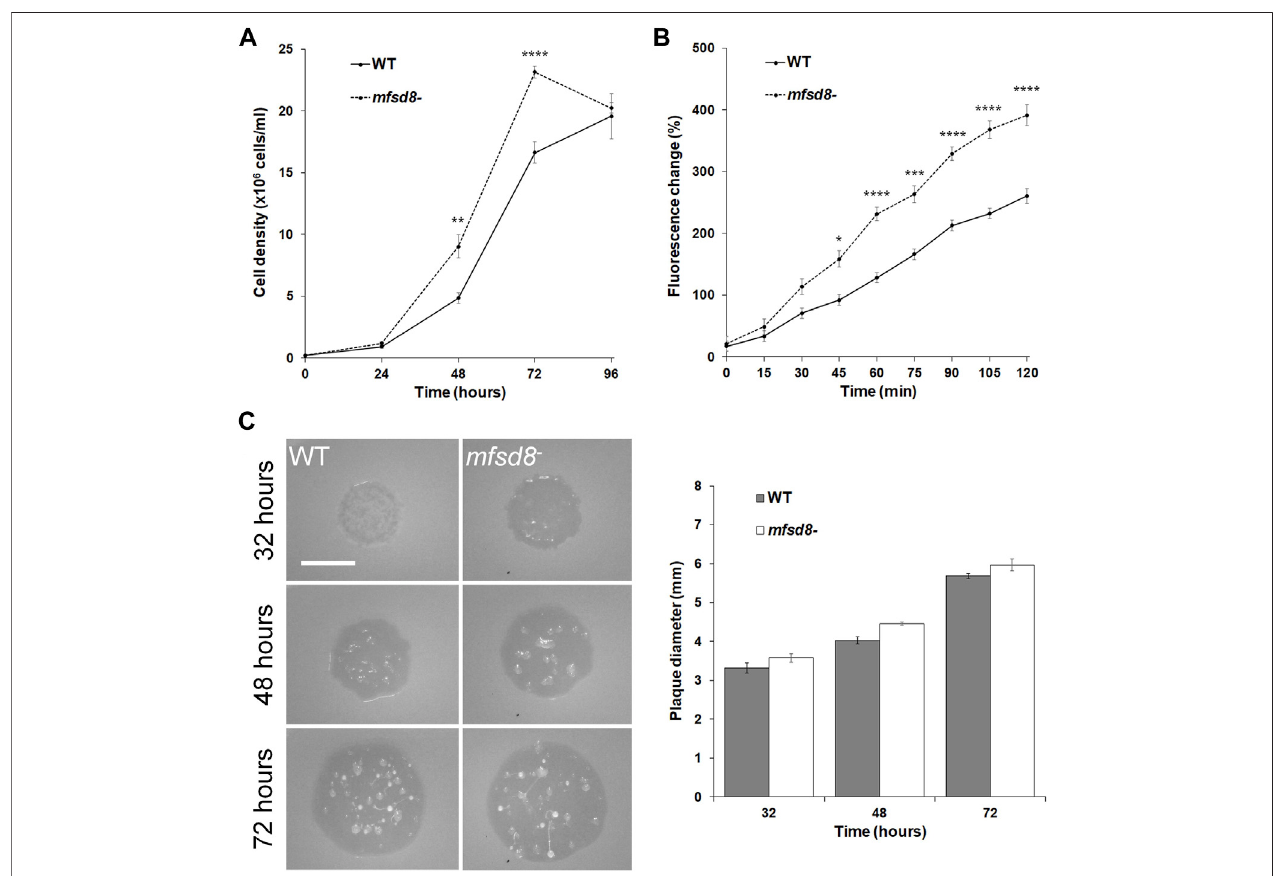
FIGURE 1 | Effect of mfsd8 -de fi ciency on cell proliferation, pinocytosis, and plaque expansion. (A) Effect of mfsd8 -de fi ciency on cell proliferation. WT and mfsd8 −